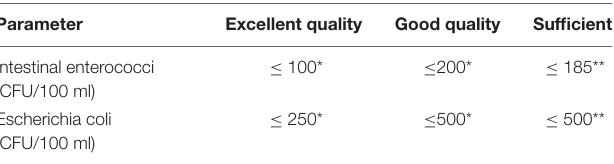
Parameter Excellent quality Good